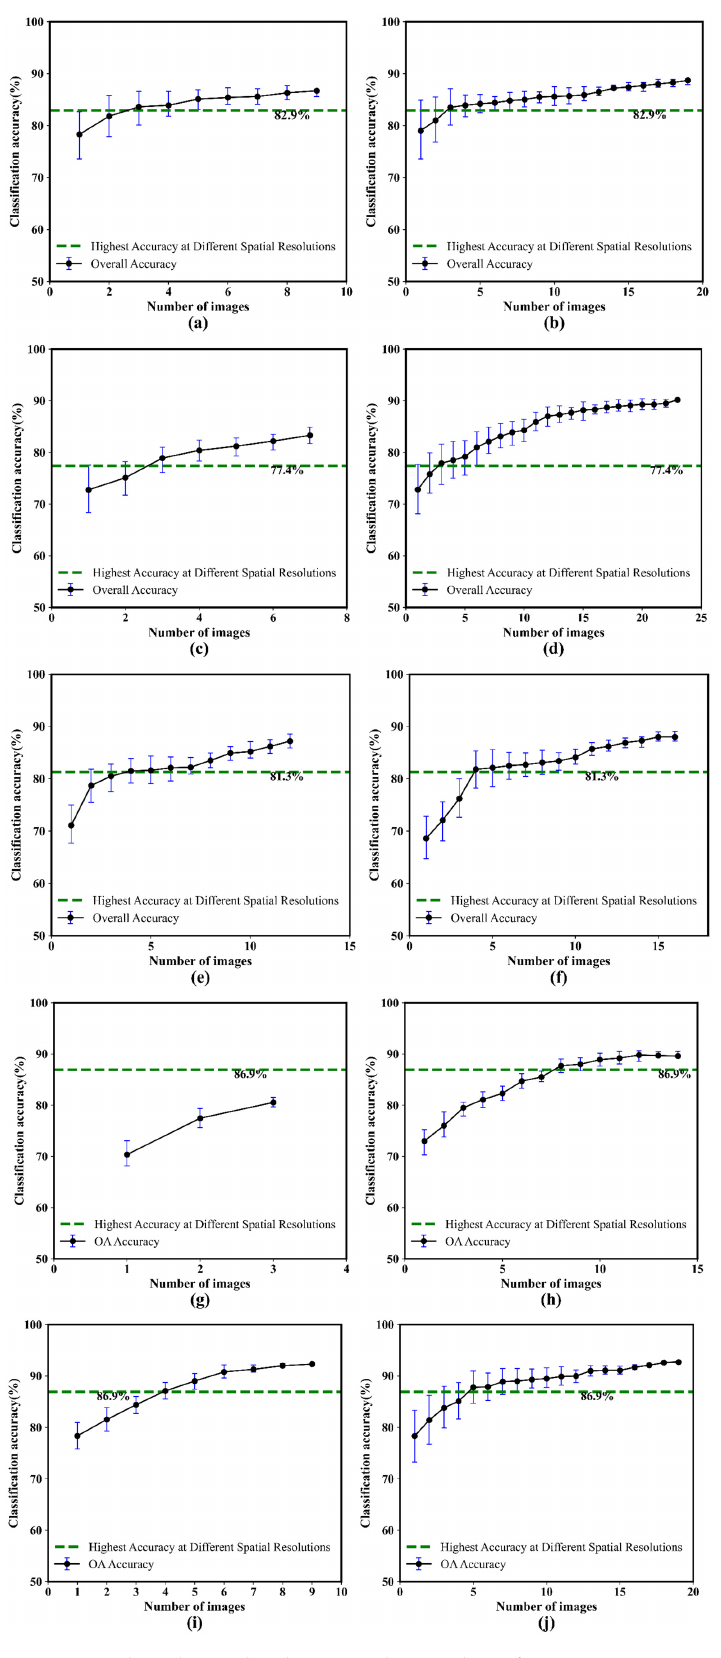
Figure 12. The relationship between the number of growing season images and OA in five study areas, where ( a , c , e , g , i ) are the results obtained using Landsat-8 images, and ( b , d , f , h , j ) are the results obtained using Sentinel-2 images.